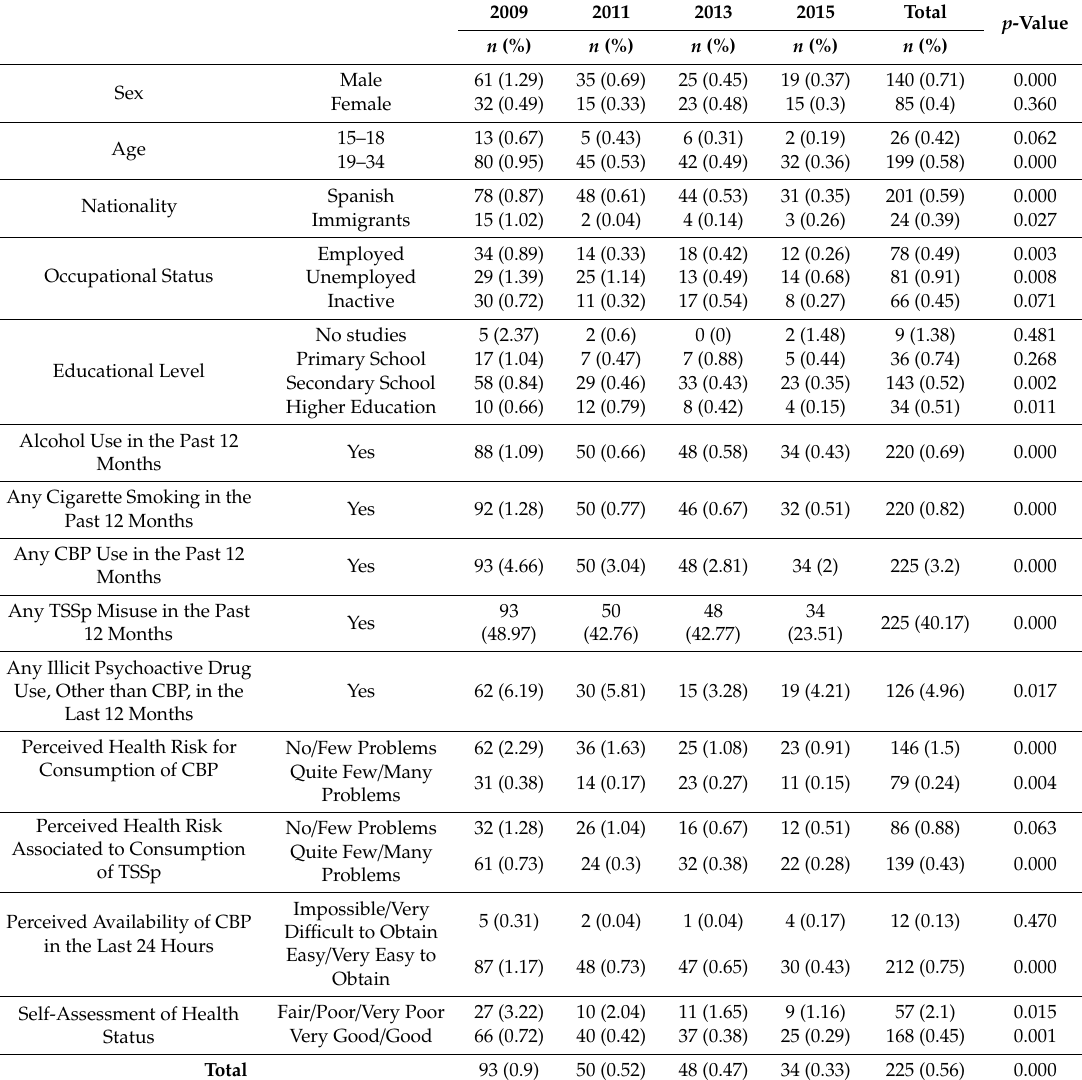
Table 1. Prevalence of co-use of cannabis and other cannabis-based products (CBP) and tranquilizers, sedatives, and sleeping pills (TSSp) misuse in young adults of both sexes, aged 15 to 34 years in Spain, according to sociodemographic variables, use of licit and illicit psychoactive drugs and variables related with perceived health risk, perceived availability and CBP and TSSp consumption ages.